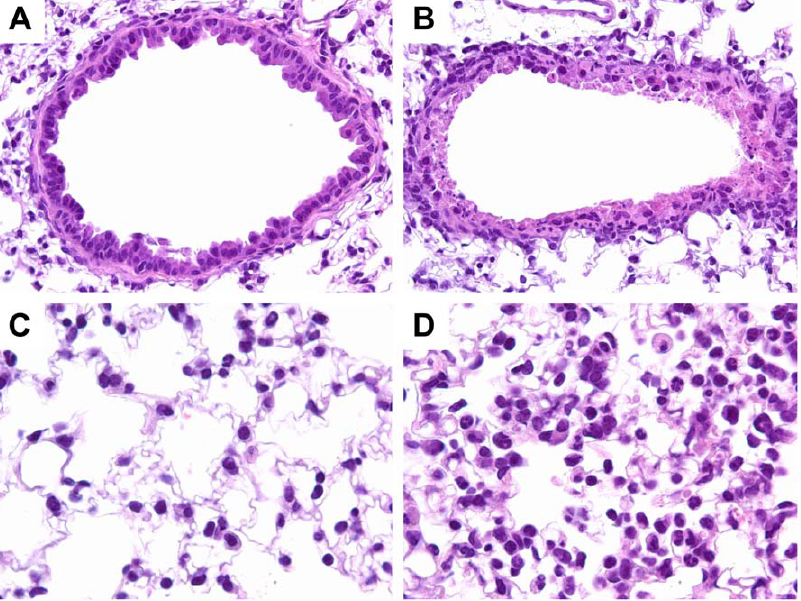
Figure 3. Hematoxylin & eosin staining of influenza-infected lungs from DBA/2J mice. (A) In the uninfected lung, the bronchiole is lined with epithelium. (B) The infected lung shows severe bronchiole epithelial necrosis. (C) In the uninfected lung, the alveoli lumens are free of cells and have thin septal walls. (D) The infected lung shows focal alveolitis with neutrophils and mononuclear cells in the alveoli lumens, and the alveolar septal walls are thickened. Magnification: 40 6 (A–B) or 80 6 (C–D).